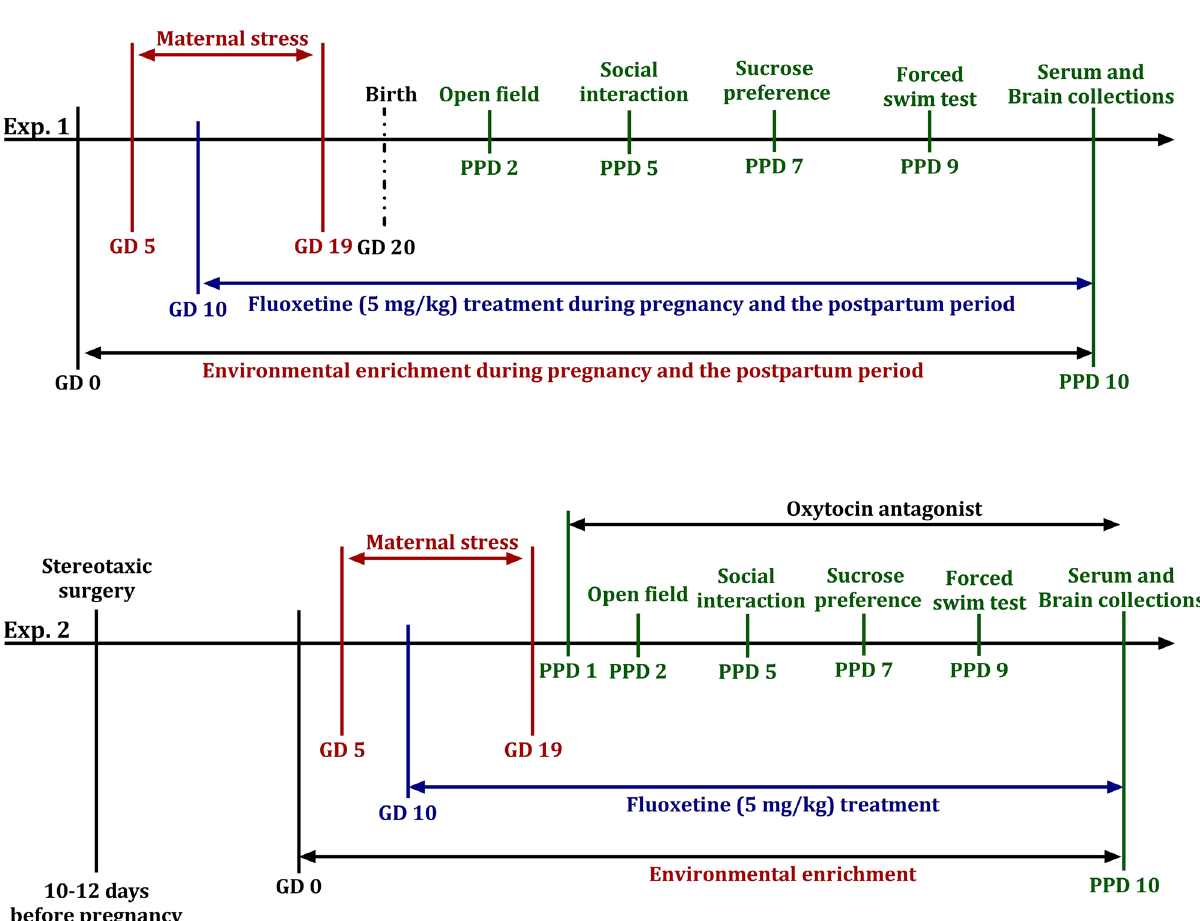
Figure 5. Experiment 1 tested the effects of gestational stress, fluoxetine treatment and environmental enrichment on anxiety (open field test), depression-like behavior (social interaction and sucrose preference, forced swim test), HPA-axis function (serum ACTH and corticosterone), and oxytocin in the brain during the postpartum period in dams. Experiment 2 investigated the FLX + EE mediated alleviation of the negative effects of gestational stress through blocking oxytocin receptor on anxiety and depression-like behavior, and HPA-axis function during the postpartum period in